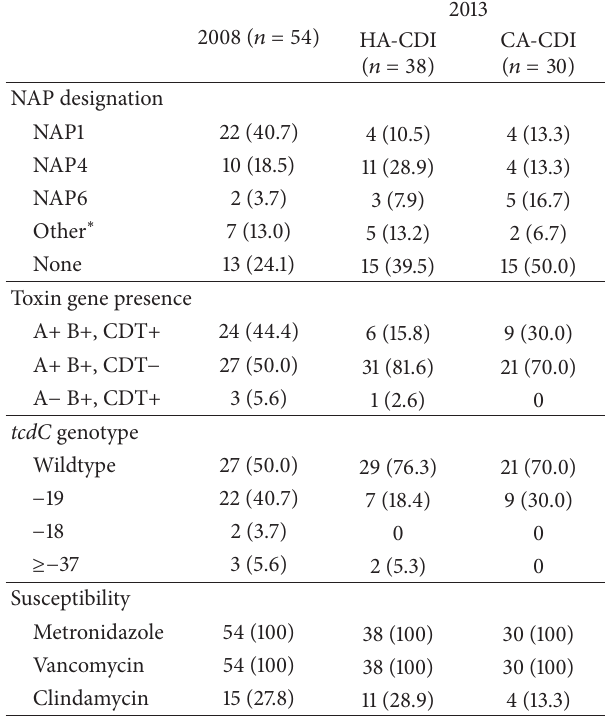
Table 3: Comparison of C. difficile from LabA (number